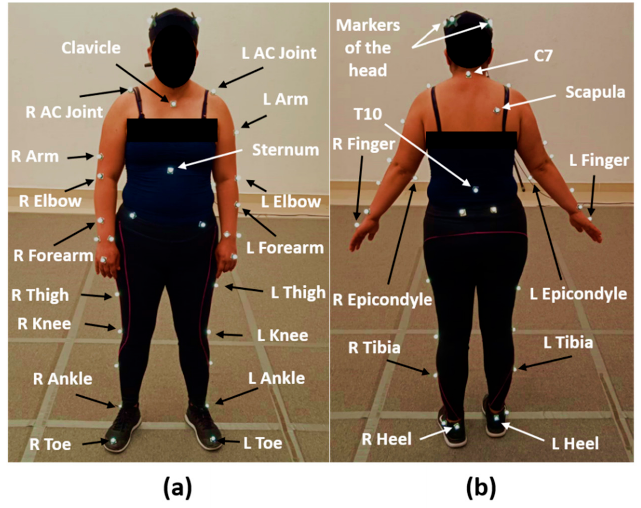
Figure 1. Placement of the markers in specific bony landmarks: ( a ) anterior view and ( b ) posterior view. R and L, the right and left sides of the evaluated volunteer.